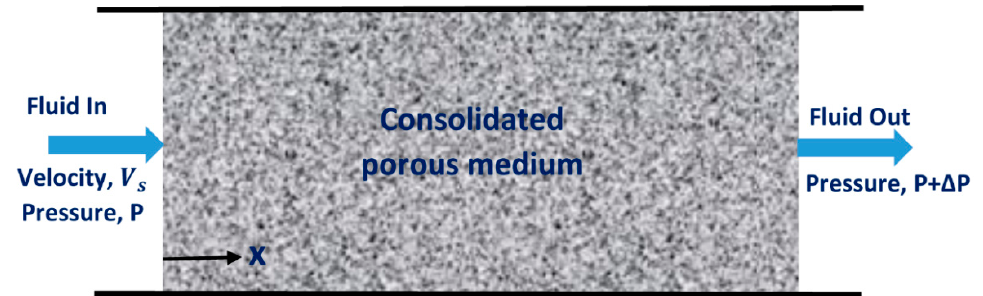
13 of 22 Figure 8. Prediction of porous medium friction factor as a function of porous medium Reynolds number. The data points are generated using the Forchheimer equation (Equation (58)). In order to apply the Forchheimer equation, the value of non-Darcy flow coefficient is needed. It can be determined experimentally. The experimental procedure to determine β involves two steps: In the first step, the permeability (cid:1863) of the porous sample is determined from Darcy’s law by restricting the experiments to low flow rates, and in the second step, the experiments are conducted at high flow rates and (cid:2010) is evaluated directly from the Forchheimer equation from the knowledge of pressure drop versus flow rate. The non-Darcy flow coefficient decreases with the increase in the permeability of the porous medium [20]. The Forchheimer equation is equally applicable to unconsolidated porous medium such as a packed bed of particles. Ergun equation is a special case of the Forchheimer equation. The Forchheimer equation, Equation (57) reduces to the Ergun equation, Equation (36), when permeability (cid:1863) and non-Darcy flow coefficient (cid:2010) are replaced by the following expressions: (cid:1863) = (cid:3031) (cid:3291)(cid:3118) (cid:3084) (cid:3119) (cid:2869)(cid:2873)(cid:2868)((cid:2869)(cid:2879)(cid:3084)) (cid:3118) and (cid:2010) = (cid:2875) (cid:2872) (cid:3436) (cid:2869)(cid:2879)(cid:3084) (cid:3031) (cid:3291) (cid:3084) (cid:3119) (cid:3440) (60) The relationships between (cid:1858) (cid:3043)(cid:3040) and (cid:1858) (cid:3029) , and (cid:1844)(cid:1857) (cid:3043)(cid:3040) and (cid:1844)(cid:1857) (cid:3029) are as follows: (cid:1858) (cid:3029) = 1.75 (cid:1858) (cid:3043)(cid:3040) (61) (cid:1844)(cid:1857) (cid:3029) = (cid:3436)600 7 (cid:3440) (cid:1844)(cid:1857) (cid:3043)(cid:3040)